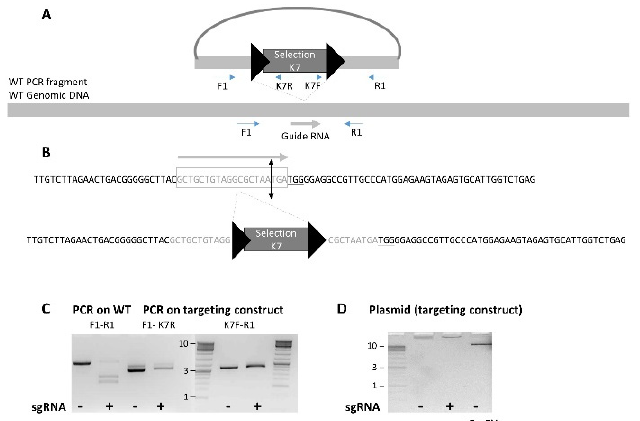
Figure 1. Example of a CRISPR design. ( A ) Scheme showing the position of the CRISPR-induced DSB relative to selection cassette. ( B ) Magnification of the sequences: a guide RNA was selected at the position of the insertion of the selection cassette so that the targeting construct would not be linearized. The PAM is underlined, and the 20 nt sequence recognized by the sgRNA is in light grey and surrounded by a rectangle. ( C ) PCR was performed on both the WT genomic DNA (F1-R1) and on the targeting construct in the region surrounding both LoxP sites (5 (cid:48) F1-K7R and 3 (cid:48) K7F-R1); the guide RNA was tested in the presence of the Cas9 protein on these PCR fragments (+); the PCR product alone is shown on the line indicated by a ( − ). Whereas a clear cut is observed on the WT PCR fragment, no DSB is observed on the PCR products from the targeting construct. ( D ) The whole targeting construct was run on a 1% agarose gel; ( − ) shows the pattern of the undigested plasmid. No linearization is observed in the presence of CRISPR (+), whereas a clear linearization (at the size of the targeting construct) is observed when the plasmid is digested with EcoRV